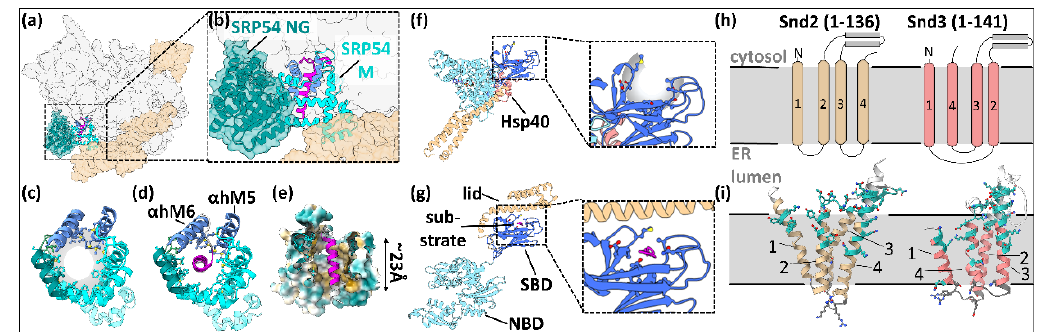
Figure 3. Details of cytosolic SP recognition and ER targeting. ( a – e ) The SRP (orange) and its central component SRP54 (teal/cyan) recognize SPs at the ribosomal exit tunnel ( a , b ) and bury the hydrophobic core in cavity formed by the SRP54 M-domain ( c , d ). α hM5/6 are colored blue. ( e ) Dimensions of the hydrophobic SRP54–SS interface. Figures based on PDB 7OBR [14]. ( f , g ) Cargo recognition by Hsp70 and Hsp40 binding, exemplified by bacterial DnaK complexed with the Hsp40 DnaJ in an open conformation [PDB 5NRO] and substrate-engaged high-affinity conformation [PDB 2KHO]. ATP hydrolysis, stimulated by substrate and Hsp40 binding, leads to a high affinity state with a closed lid domain (yellow). NBD: nucleotide binding domain; SBD: substrate binding domain. ( h,i ) AlphaFold 2 predictions of the ER-resident membrane proteins Snd2/3 from S. cerevisiae (entries Q99382 and P38264). TM helices are numbered Membrane topologies are based on UniProt. Both predicted structured possess hydrophilic vestibules that reach into the presumed membrane environment. Helices are numbered.